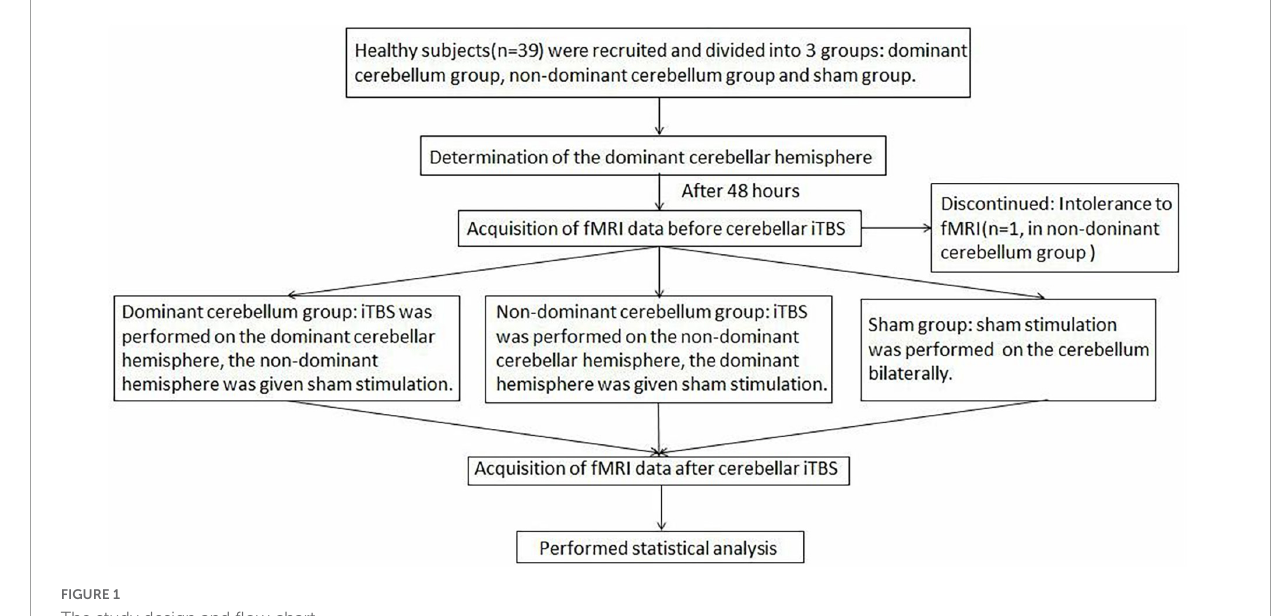
FIGURE1 The study design and flow chart.